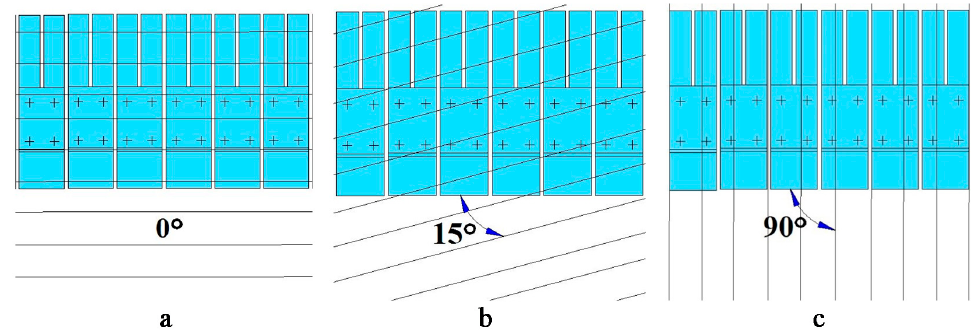
Figure 5. Direction of seam mining and support unit displacement relative to a system of natural fissility in the roof rock layers: ( a ) 0°, ( b ) 15° and ( c ) 90°. It should be noted, however, that the parameters described above can be used either with the available sandstones in the roof or at their non-availability, as all the wall enclos- ing rocks have their own fissility of 0° [29].